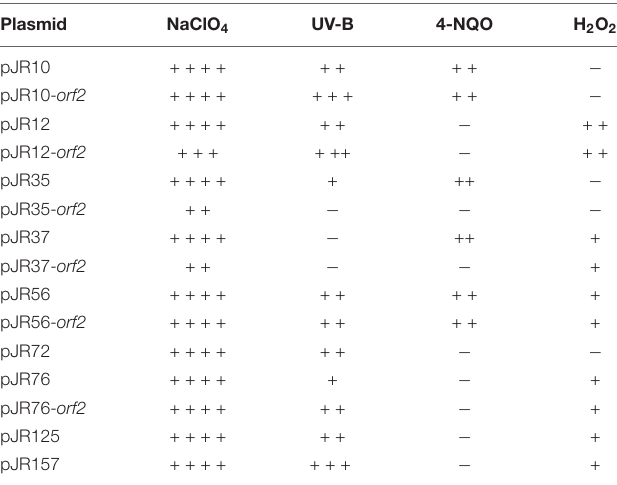
TABLE 2 | Cross-resistances showed by perchlorate-resistant clones and individual predicted ORFs.